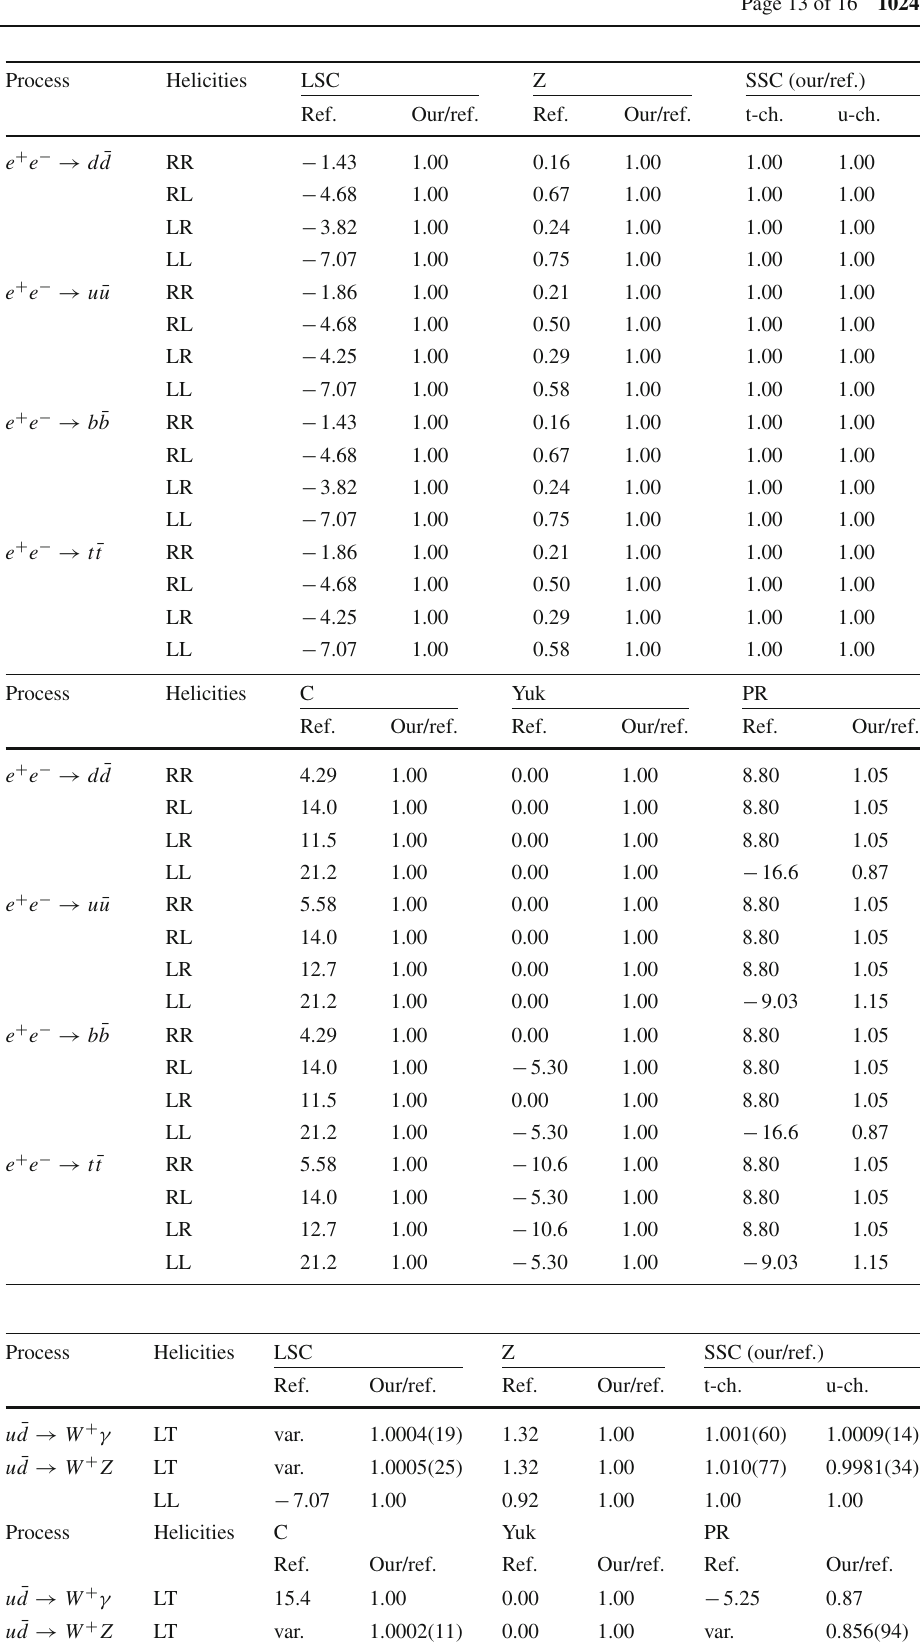
Table 2 Same as Table 1, but for lepton-induced quark pair production, with reference values again taken from [1]